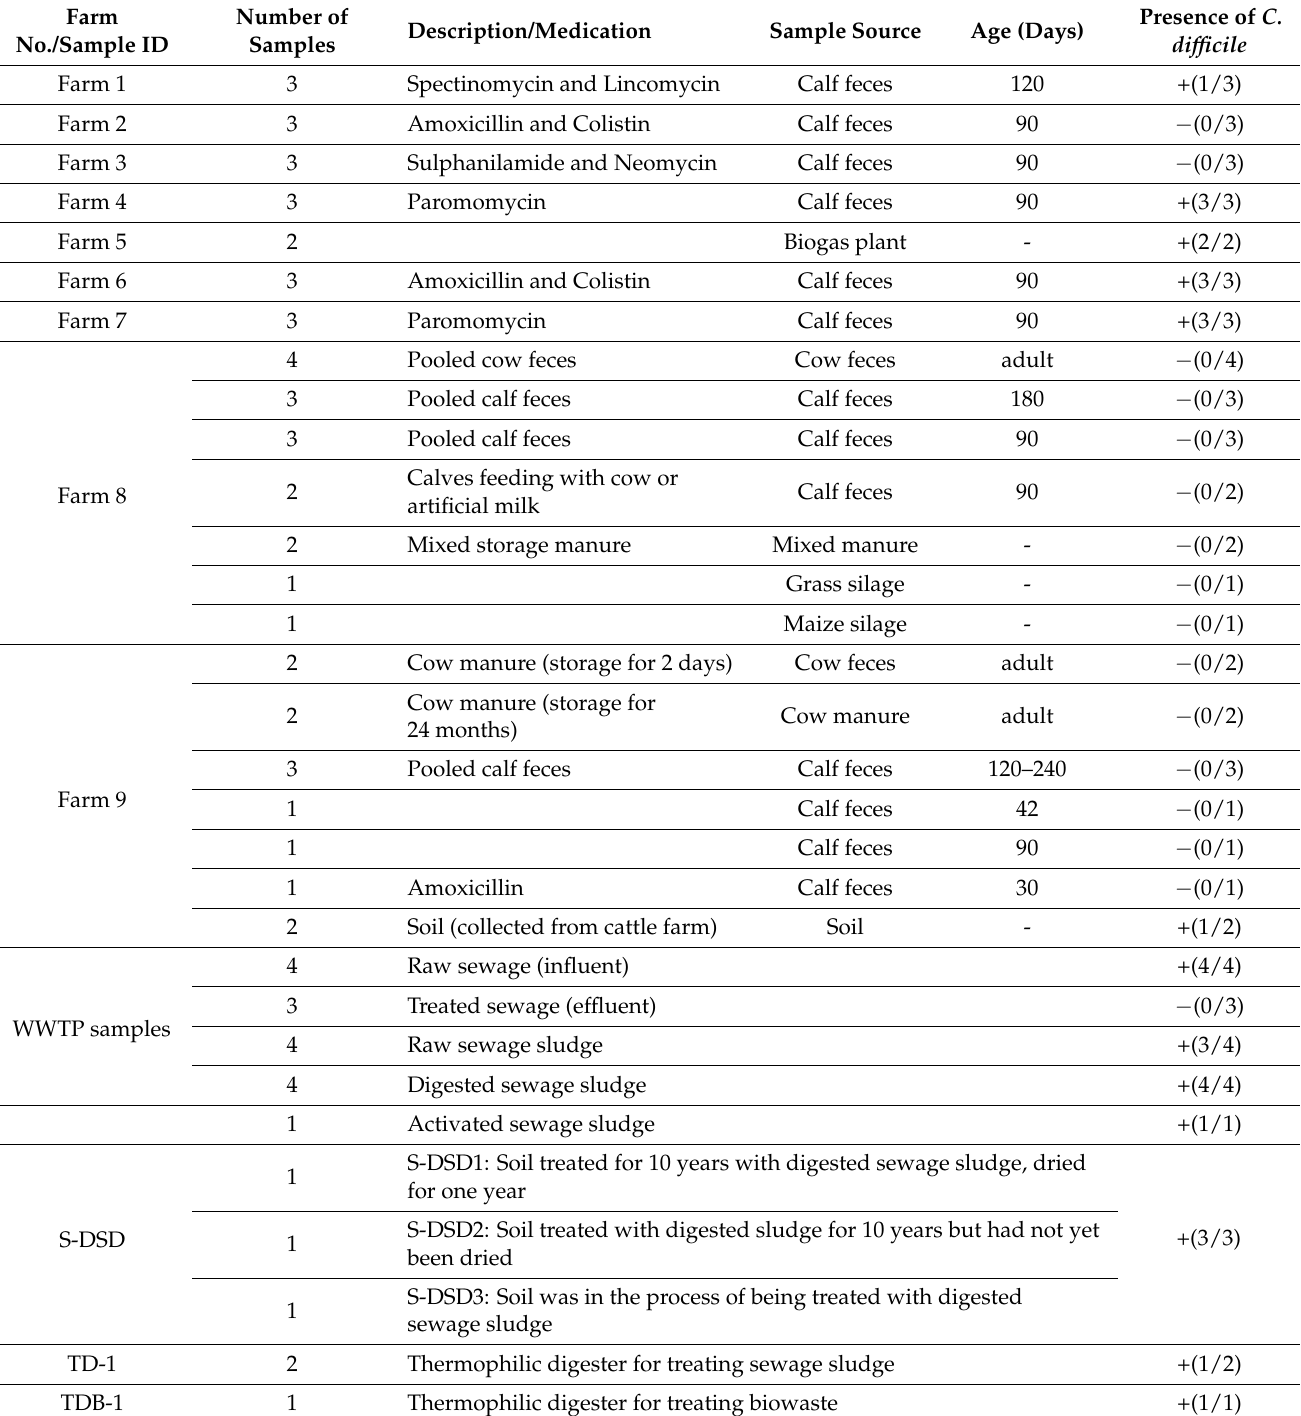
Table 1. Presence of C. difficile in diverse fecal environmental samples after selective